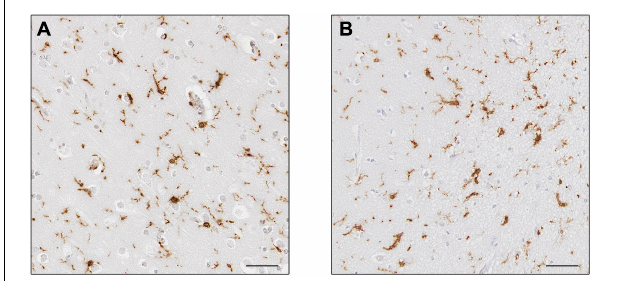
FIGURE 4 | Expression of Iba1+ microglia. Microglia in controls (A) and Alzheimer’s disease (B) . Cells in (B) appear to have thicker processes. Scale bars = 50 µ